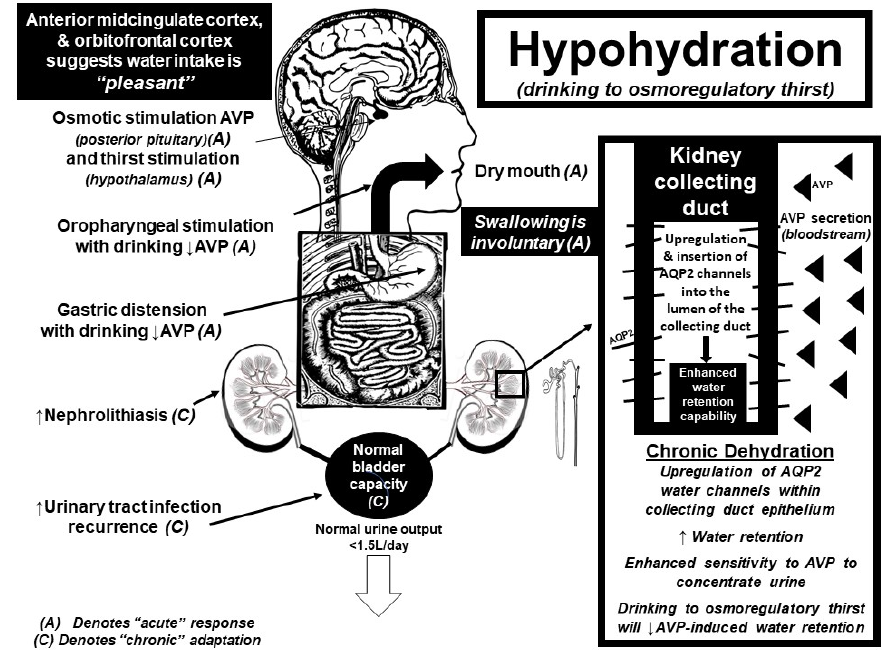
Figure 3. Summary diagram of acute (A) and chronic (C) physiological responses and potential pathologies associated with drinking to thirst when hypohydrated.